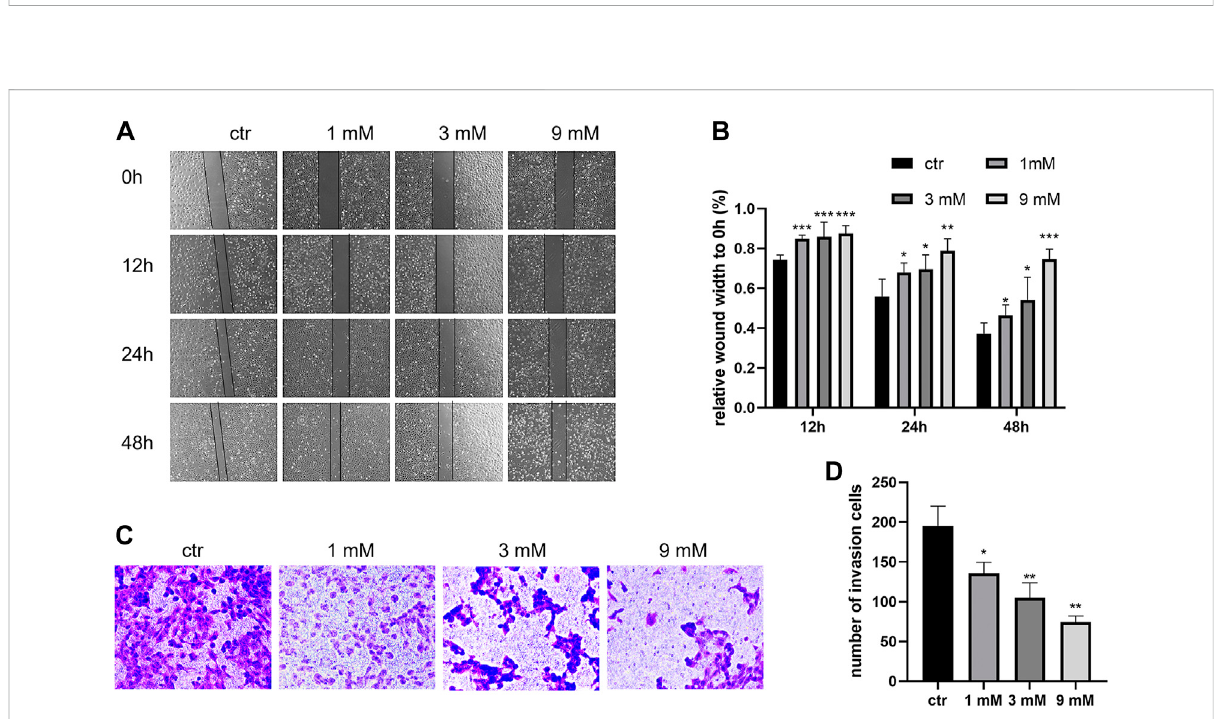
FIGURE 2 Metformin suppressed the migration and invasion of Daoy cells. (A,B) Scratch assay was used to assess the migration ability of Daoy cells after metformintreatment( n =4). (C,D) TranswellassaywasusedtoassesstheinvasionabilityofDaoycellsafter24 hofmetformintreatment( n =3).Data are presented as the mean ± SD, t-tests were used to determine the signi fi cance. * p < 0.05; ** p < 0.01; *** p < 0.001 compared with the control